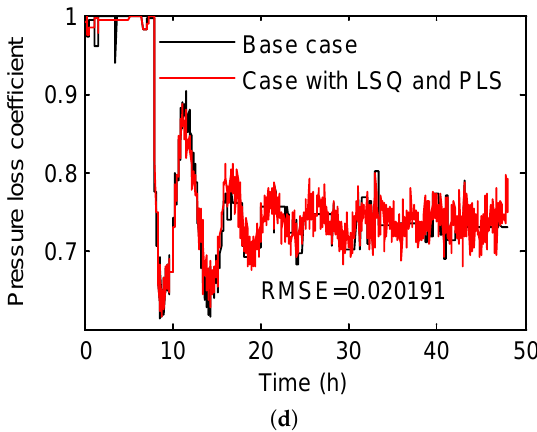
Figure 12. Fault diagnosis under fault 7 ( a ) based on Vector II data, but without second PLS; ( b ) based on Vector II data and with second PLS; ( c ) based on Vector I data, but without second PLS; ( d ) based on Vector I data and with second PLS.